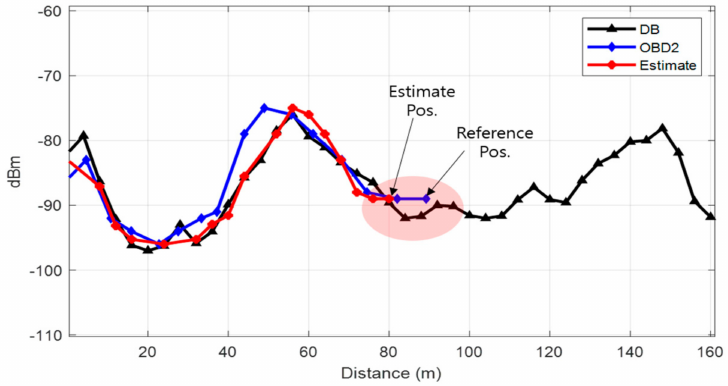
Figure 16. The epoch with the biggest error in scenario 1. Weak RSS is continuously received in this area.